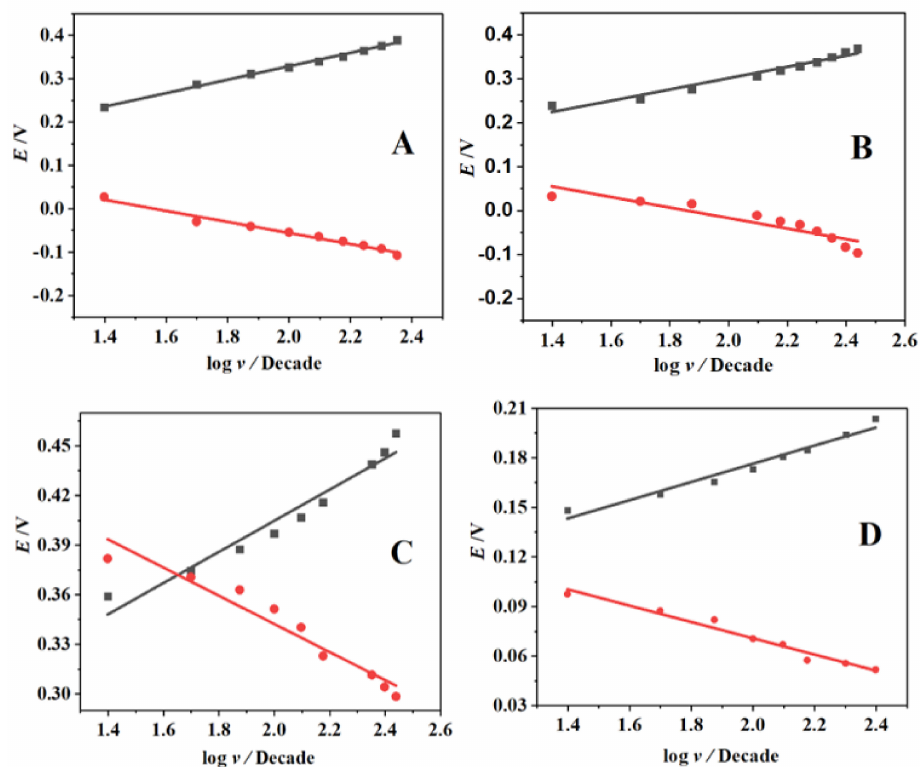
Figure 9. The relationship between E p and the logarithm of the scan rate ( v) for ( A ) SPAuE, ( B ) SPAuE- CuO, ( C ) SPAuE-SPEEK, and ( D )